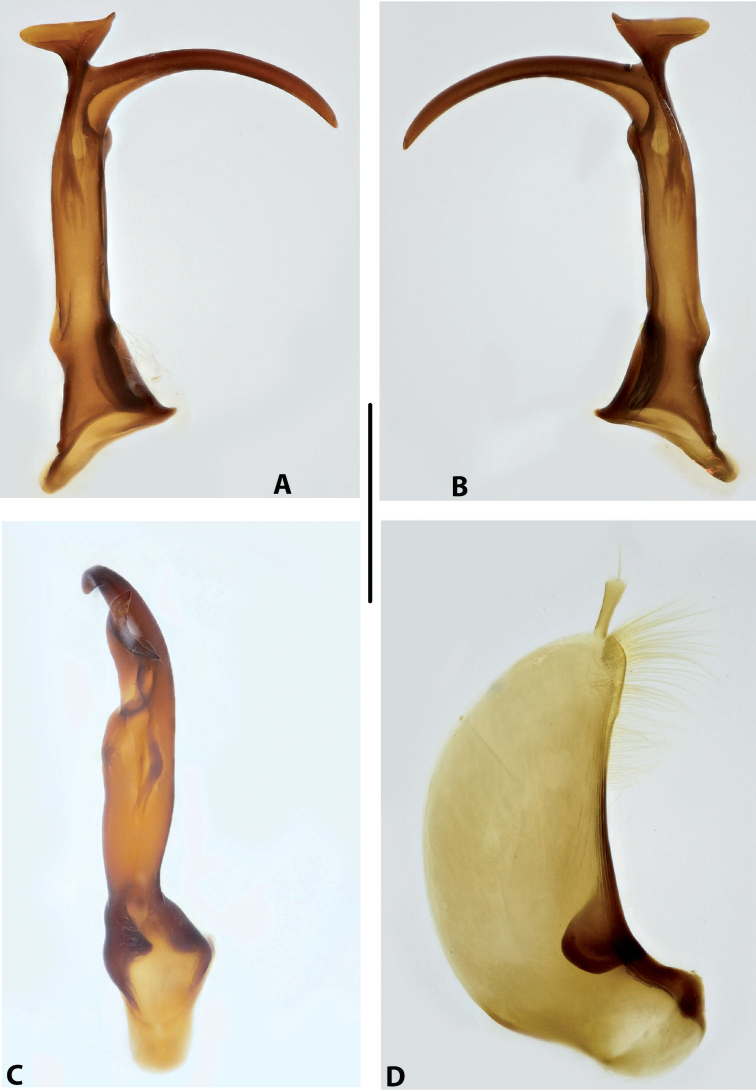
Copelatus
portiorA median lobe in lateral view, right side B median lobe in lateral view, left side C median lobe in ventral view D left paramere in external view. Scale bar: 0.5 mm.